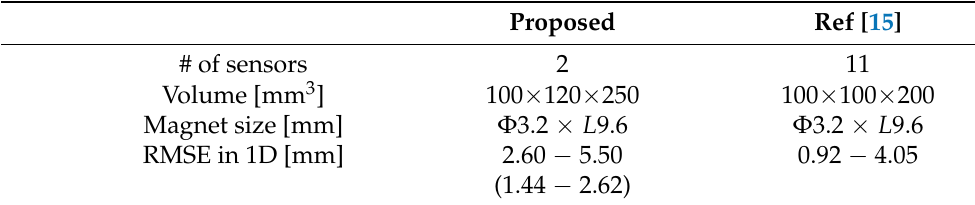
Table 5. Comparison of the tracking performance of the proposed and the other magnetic sensor-based tracking systems. For our approach, the RMSE when z = 250 mm is excluded is in the